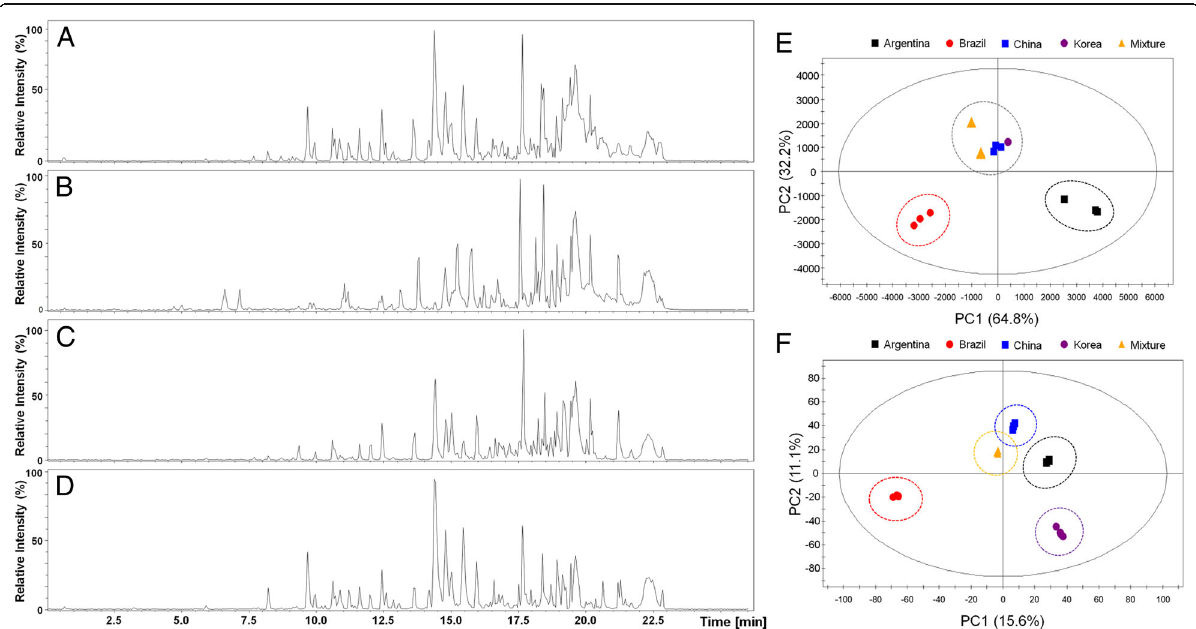
Fig. 3 Total ion chromatograms of EEP samples from a Argentina, b Brazil, c China, and d Korea, as obtained by UPLC/FT-ICR MS. PLS-DA models obtained using UPLC and UPLC/FT-ICR MS data. Quantitation data of ten phenolic compounds using UPLC was used for model ( e ), whereas selected key molecular features (VIP > 4, and fold change ≥ 2 or ≤ − 2 or observed only in each sample) obtained by FT-ICR MS analysis were used to generate model ( f )